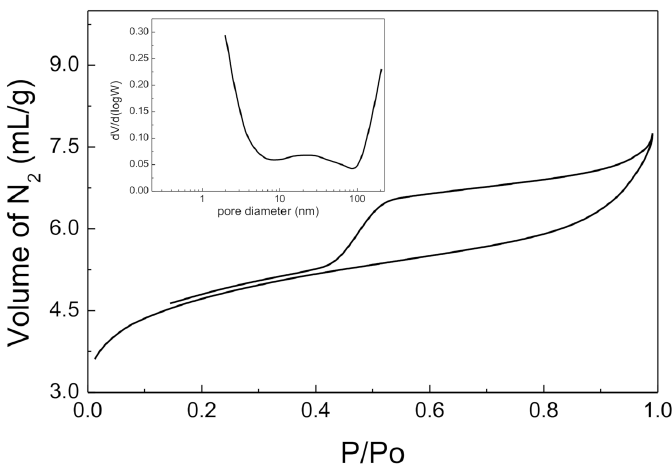
Figure 2. Adsorption-desorption isotherm for the Na–BC sample. Inset: Pore size distribution for the Na–BC